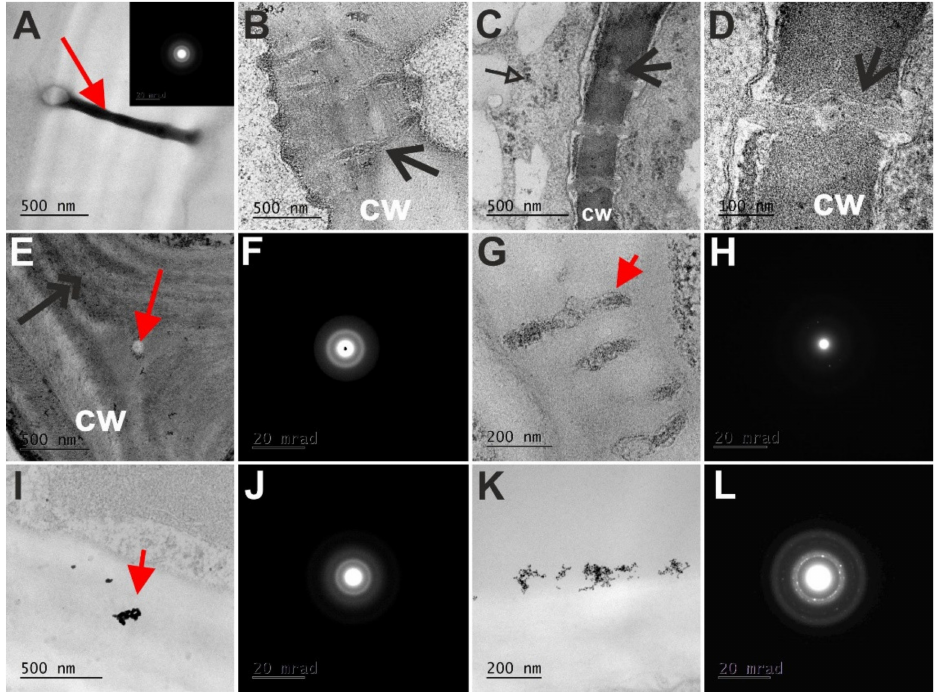
Figure 1. High-resolution transmission electron microscope (HRTEM) images of sections from barley roots that had been treated with the Au-NP. ( A ) The PD in the wall. The appearance of the PD is an artefact that was caused by mistakes in the sample preparation procedure; inset—diffraction pattern that that indicates that the black color (indicated by red arrow) is not NP. ( B ) The PD with electron-dense material inside (indicated by black arrow), but as was proven by the diffraction pattern (see inset on ( A )), the electron-dense material was not NP. ( C ) Cell wall traversed by the PD with electron-dense spots (indicated by black open arrow), which are not NP proved by diffraction pattern. Many electron-dense dots were present in the cytoplasm but were also not NP (black arrow). Note that the dark colouration of the cell walls resulted from the presence of pectins. ( D ) Similar to Figure ( C ), none of electron-dense particles were NP (black arrow; diffraction patterns were the same as for ( A )). ( E ) Cross-section through the root cell walls. Note the electron-dense bands in the wall (black double arrow), which were not NP, but just a higher amount of pectins compared to the other parts of the walls (cw). Such an image is especially characteristic for the middle lamella. Electron-dense dot (indicated by red arrow) is not NP. ( F ) Diffraction pattern of the dot from Figure ( E ). ( G ) PD with electron-dense material inside (red arrow). ( H ) Diffraction pattern of the electron-dense material from the PD that indicated that this material is amorphous, thus not NP. ( I ) Electron-dense particles within the cell wall of barley roots (red arrow). ( J ) The diffraction pattern clearly supports the claim that the observed electron-dense particles were not NP. ( K ) Transverse section through the cell wall with many electron-dense particles. ( L ) The diffraction pattern indicates that the observed electron-dense particles are